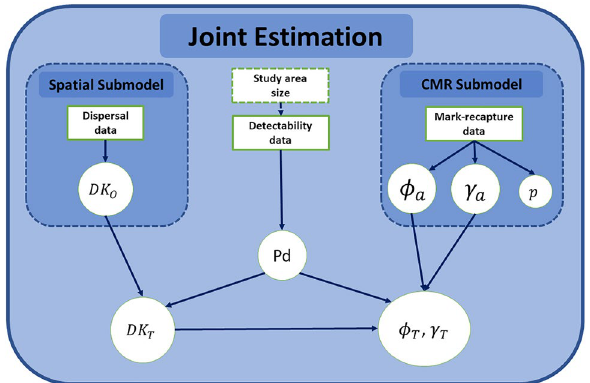
Figure 6. Diagram of the Joint Estimation framework. Data types are inside solid squares (study area size is inside a dashed square as study area information is implicitly provided by detectability data). Parameters are shown inside circles. Parameters DK o and DK T stand for the observed and the true dispersal kernel respectively. Parameters φ, γ, and p from the CMR submodel account for apparent survival, apparent recruitment, and recapture estimates. Parameter P d provides information on detectability at different dispersal distances for every individual and links the spatial and the CMR submodels. Note that the absence of parameter P d would lead to a separate (i.e., unlinked) estimation of survival and